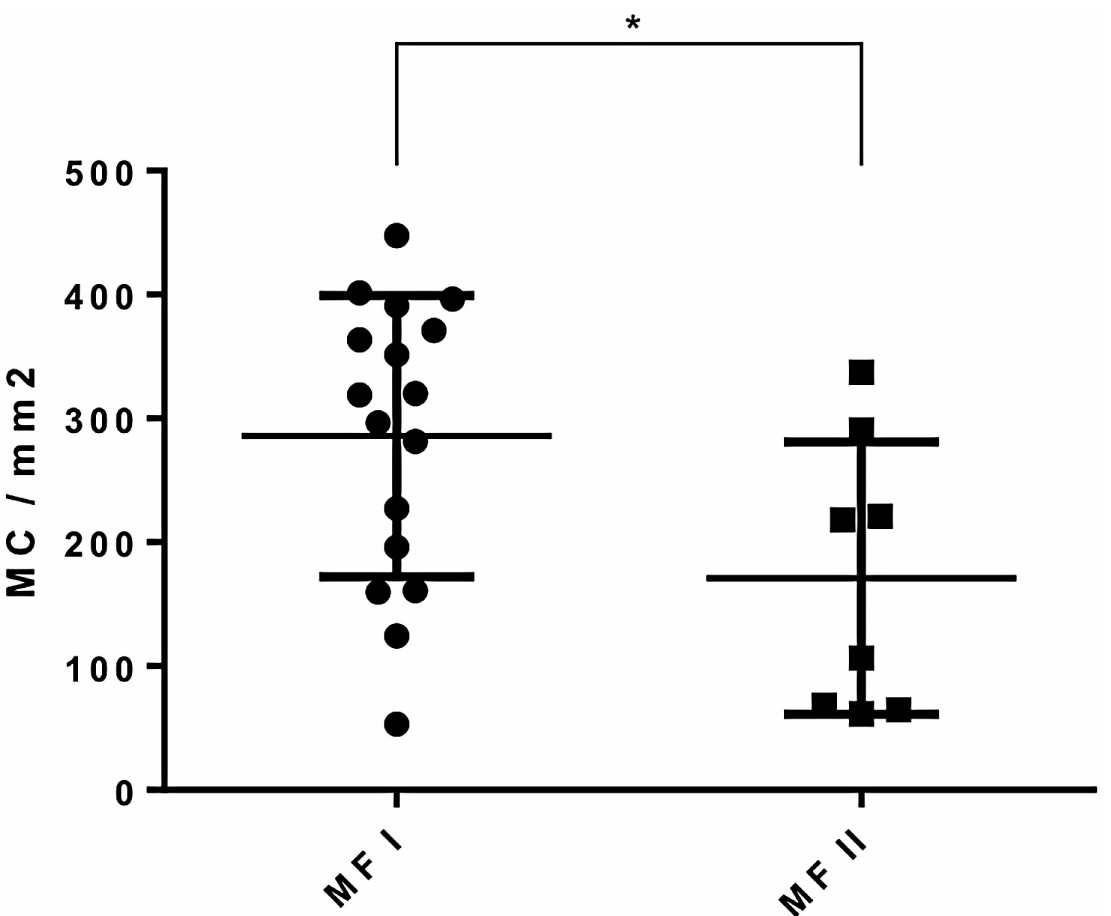
Fig 4. Mast cell count per mm 2 as measuredby tissueFAXS systemshowing the difference between combined early MF stages IA and IB and combined advanced stages MF IIA and IIB. Significantly highermast cell counts were found in stage I